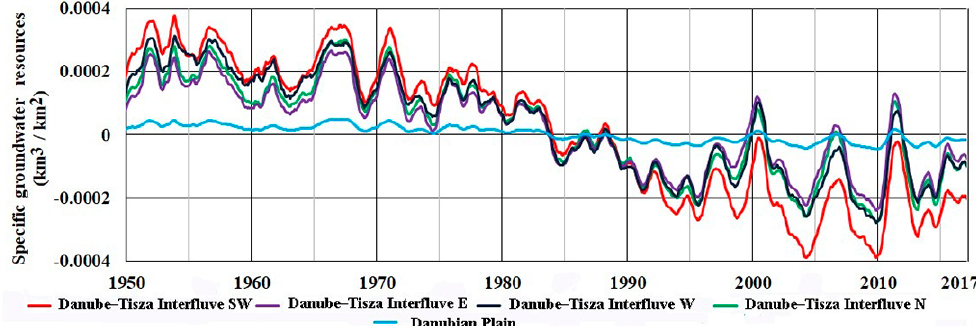
Figure 5. Changes in specific water resources in five sub-regions of the Danube-Tisza Interfluve